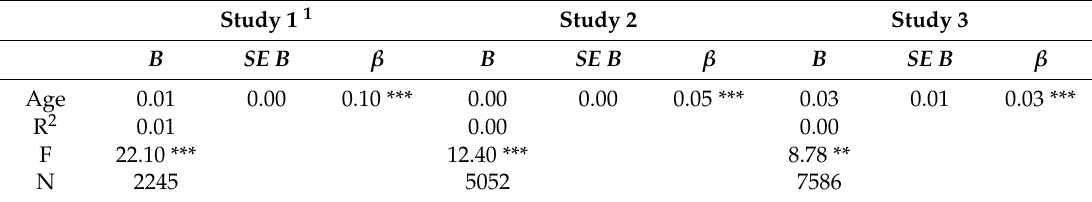
Table 8. Results of Linear Regression Analyses of Age Predicting Foxiness.